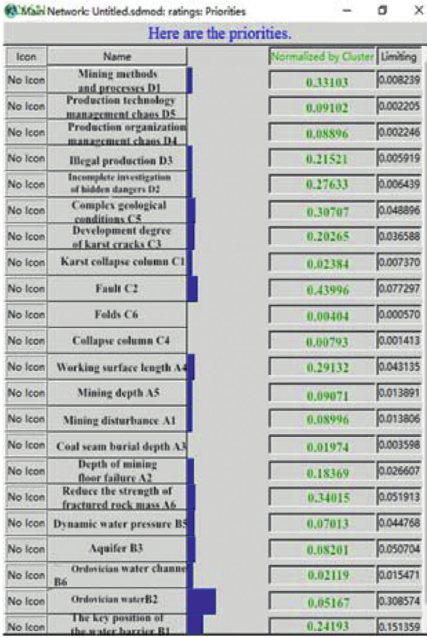
Figure 8: Index comprehensive weights chart. Table 5: Scoring criteria for water inrush disaster indicators in Y coal mine.